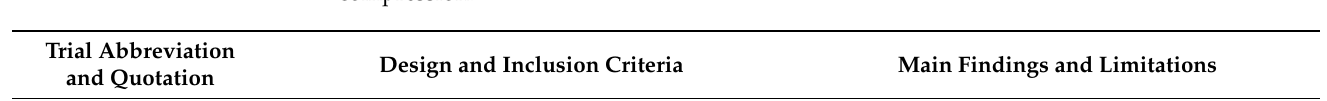
Table 2. Overview of selected studies on automated mechanical vs. conventional manual chest